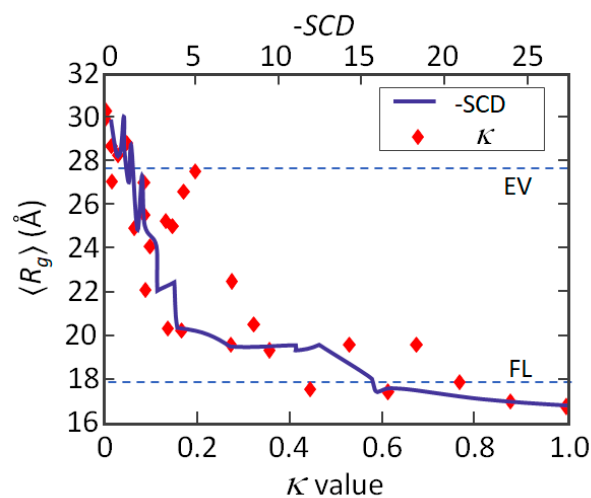
Figure 2. Parametrization of charge patterning. Ensemble-averaged radii of gyration < R g > for sequence variants of the (Glu-Lys) 25 system versus κ [25] and SCD [44]. The two dashed lines intersect the ordinate at < R g > values expected for the sequences of the (Glu-Lys) 25 system, modeled as excluded volume (EV)-limit polymers or as Flory random coils (Flory limit, FL), respectively (figure adapted from [46] .